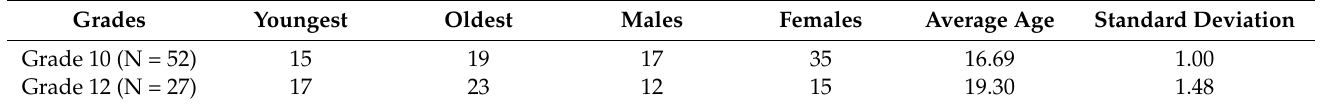
Table 3. Learners’